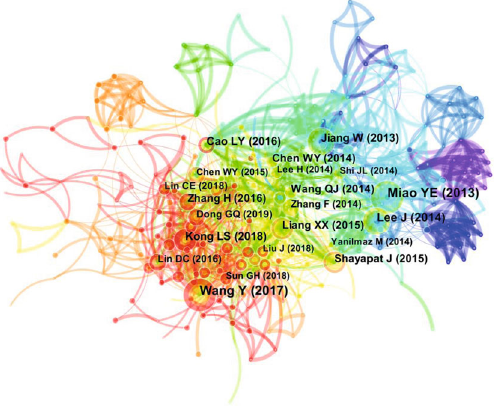
Figure 9: Literatures cocitation